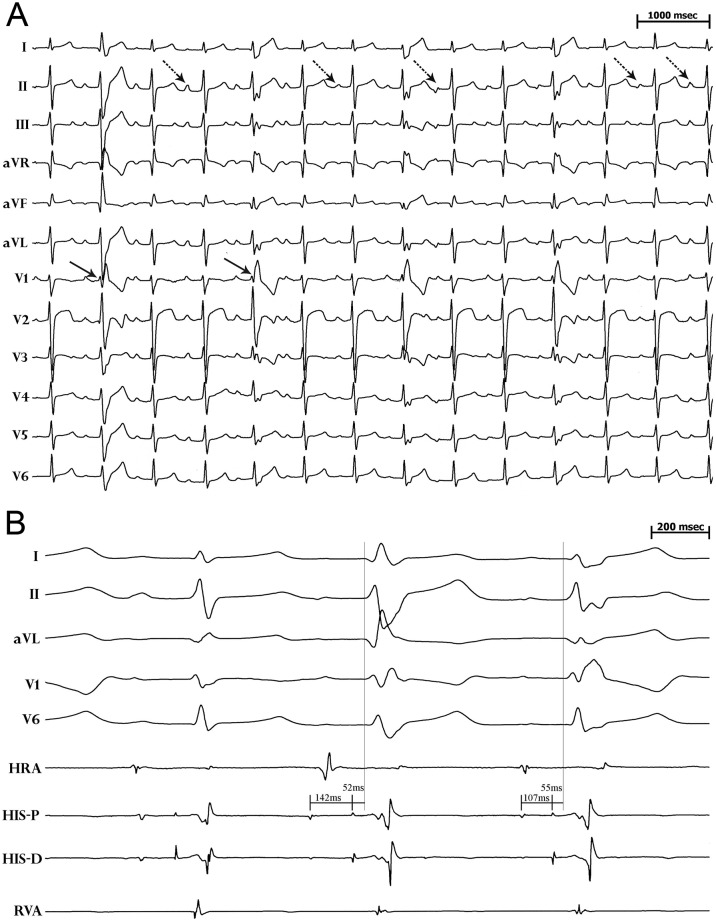
ECG and intracardiac recordings.A. Resting 12-lead ECG showing sinus tachycardia, mild QTc prolongation (470ms), atypical ST elevation in lead V2, rate-independent varying QRS aberrancy (solid arrow), and rate-independent changes in P wave morphology (dashed arrow). B. Surface ECG and intracardiac electrograms during sinus rhythm showing varying QRS aberrancy and normal HV interval of 55ms. Abbreviations: surface ECG leads I, II, aVL, V1, V2; bipolar electrograms from high right atrium (HRA), His bundle-proximal (HIS-P), His bundle-distal (HIS-D), right ventricular apex (RVA).